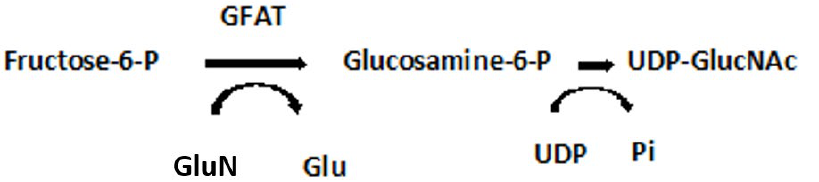
Figure 5. Hexosamine Pathway. GFAT, glutamine:fructose-6-phosphate-aminotransferase; UDP- GlucNAc, Uridine-5-diphosphate-N-acetylglucosamine c; GlutN, Glutamine; Glu, Glutamic acid; UDP, Uridine 5′ -diphosphate; Pi, inorganic phosphate.